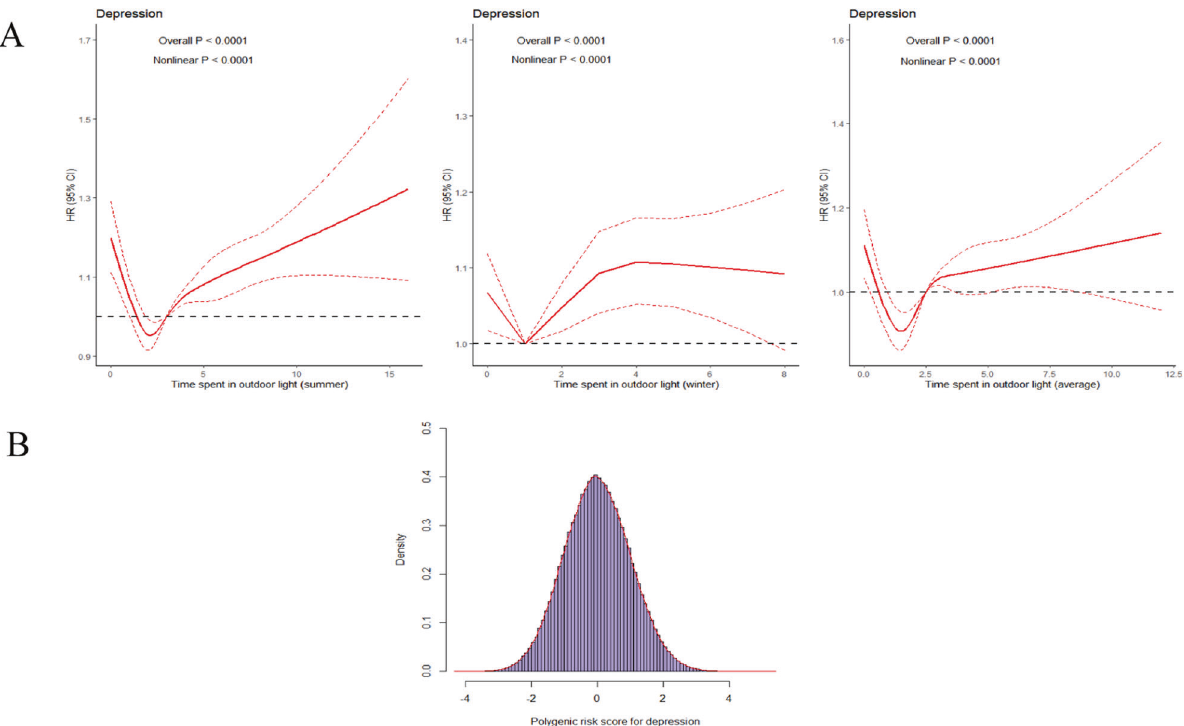
Fig. 1 Risk of incident depression according to time spent in outdoor light and genetic risk. A The correlation between time spent in outdoor light and incident depression during follow-up; B Distribution of polygenic risk score by incident depression. HR hazard ratio, 95% CI 95% con fi dence interval. Adjusted for age, gender, education, Townsend deprivation index, smoking status, drinking status, body mass index, total physical activity, sleep duration, fracture history, vitamin D supplement, hearing loss, use of sun/UV protection, PM 2.5 , hypertension, hyperglycemia, and genetic